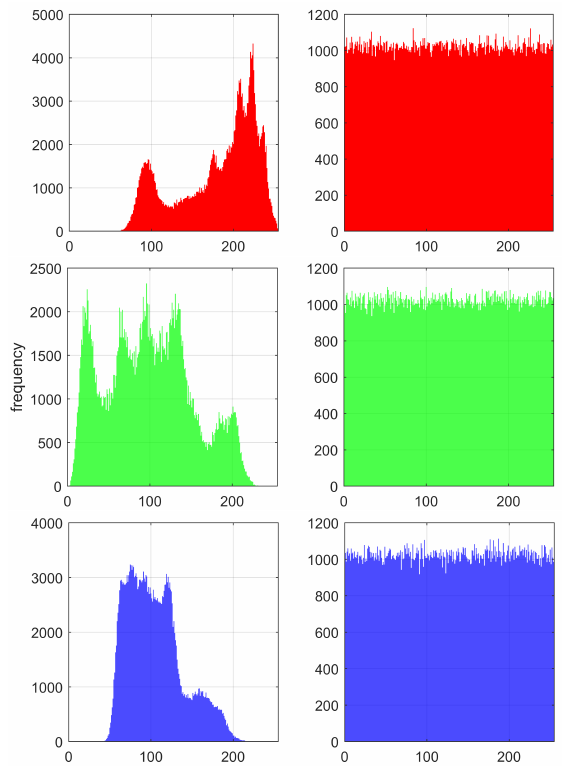
Figure 13. Histograms of the Lena image encrypted using HNNset2 from Table 2. Original images on the left and the R, G and B encryption on the right.